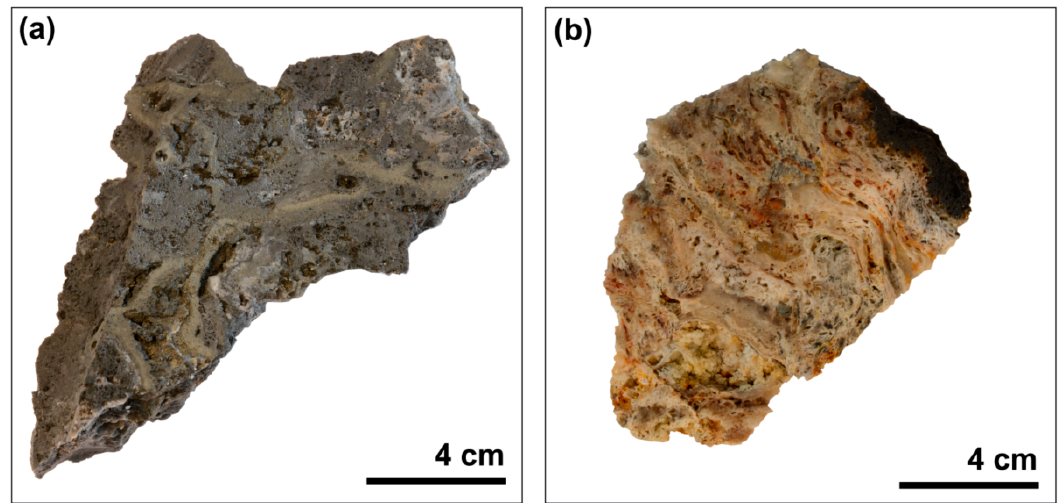
Figure 4. Cut ( a ) black and ( b ) white end ‐ member hand samples of vent material; the majority of the material is a complex amalgamation of both. Sulphide lenses exist within the fine grained black groundmass, which also contains abundant disseminated sulphides.